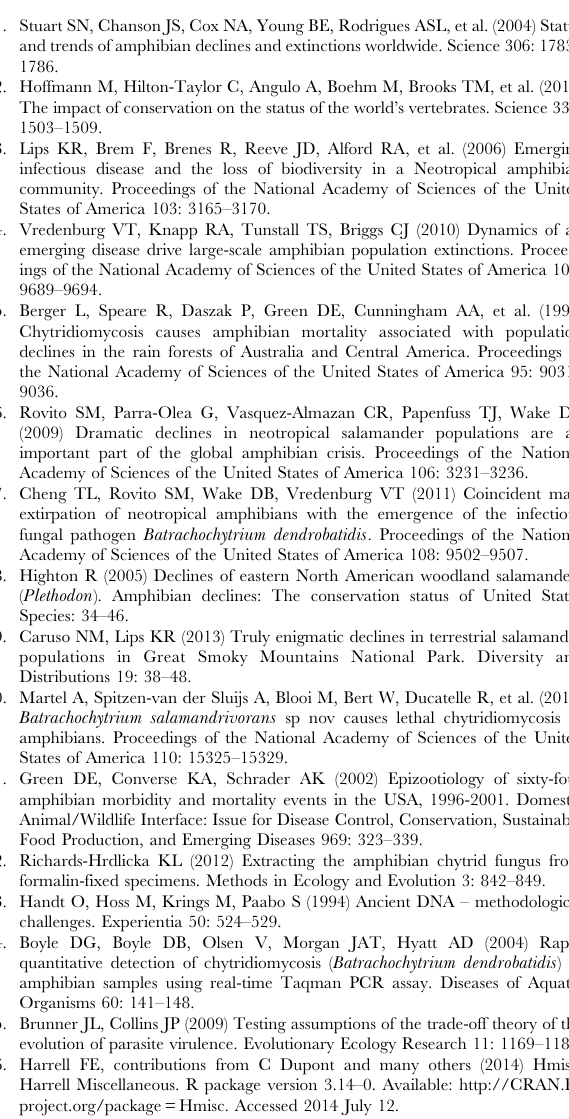
Table S2 National Museum of Natural History (USNM) specimen data for salamanders tested for Bd